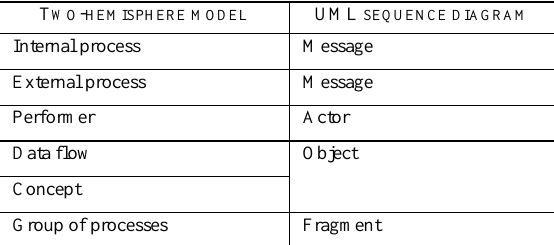
M APPING OF THE SOURCE AND TARGET